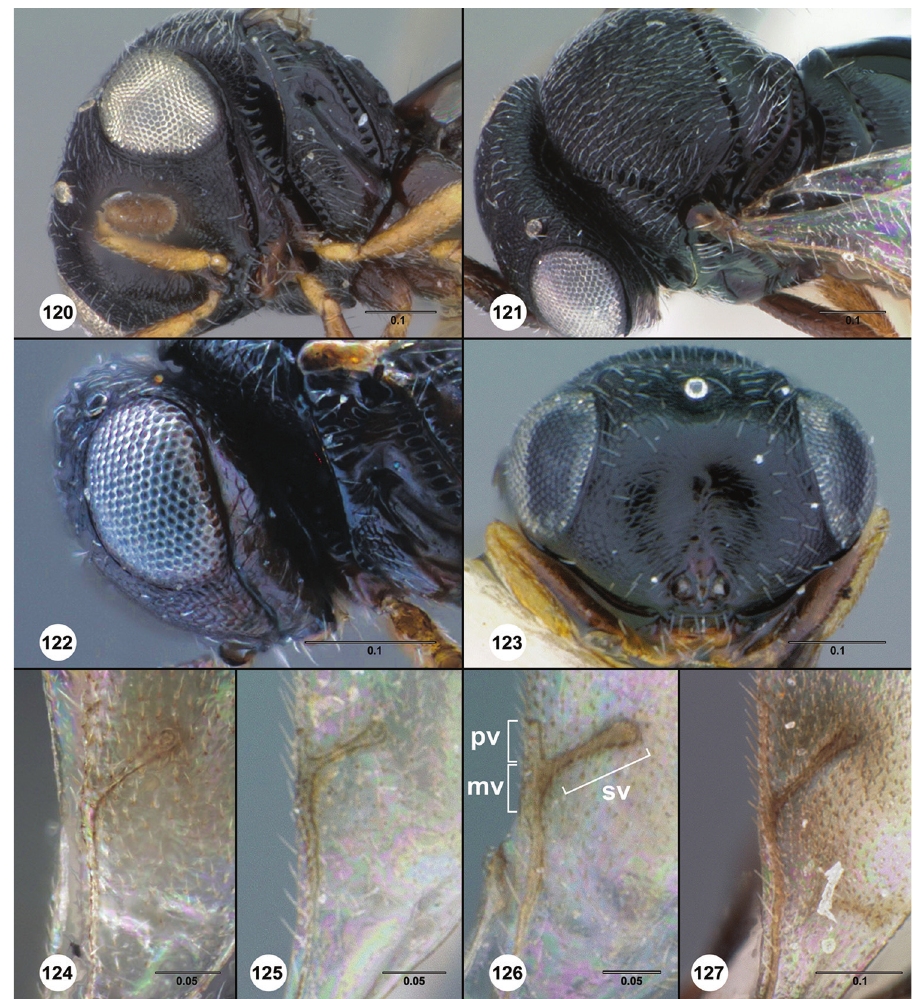
Metanotal trough: foveate, foveae occupying more than half of metanotal